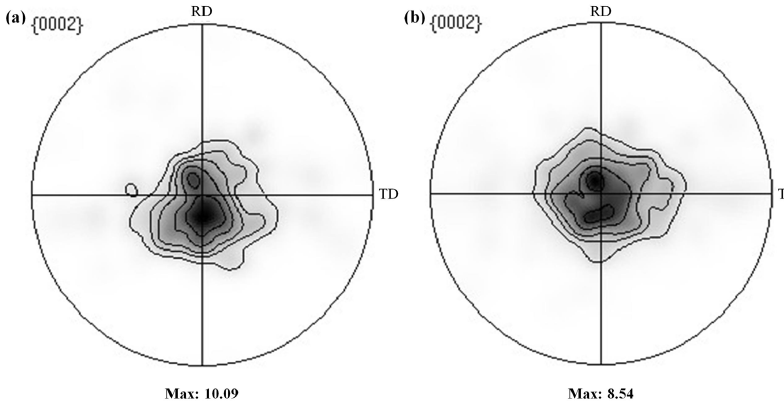
Fig. 7. Pole figures of annealed sheets: (a) ingot and (b)